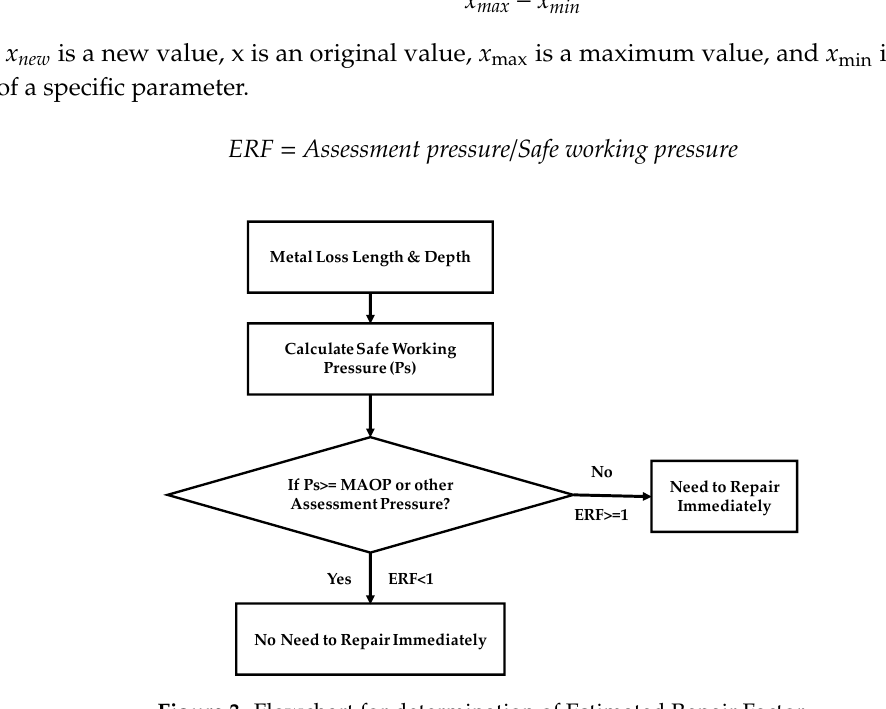
Figure 3. Flowchart for determination of Estimated Repair Factor.